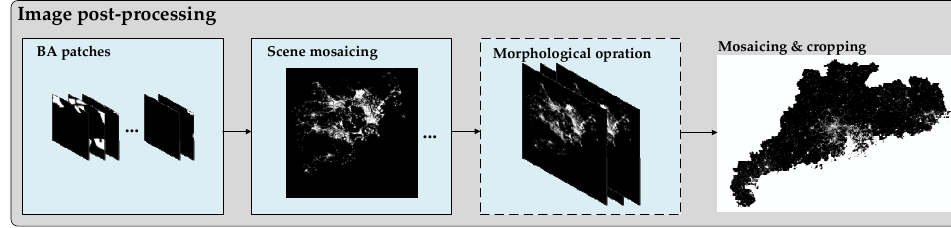
Figure 5. The process of image post-processing.